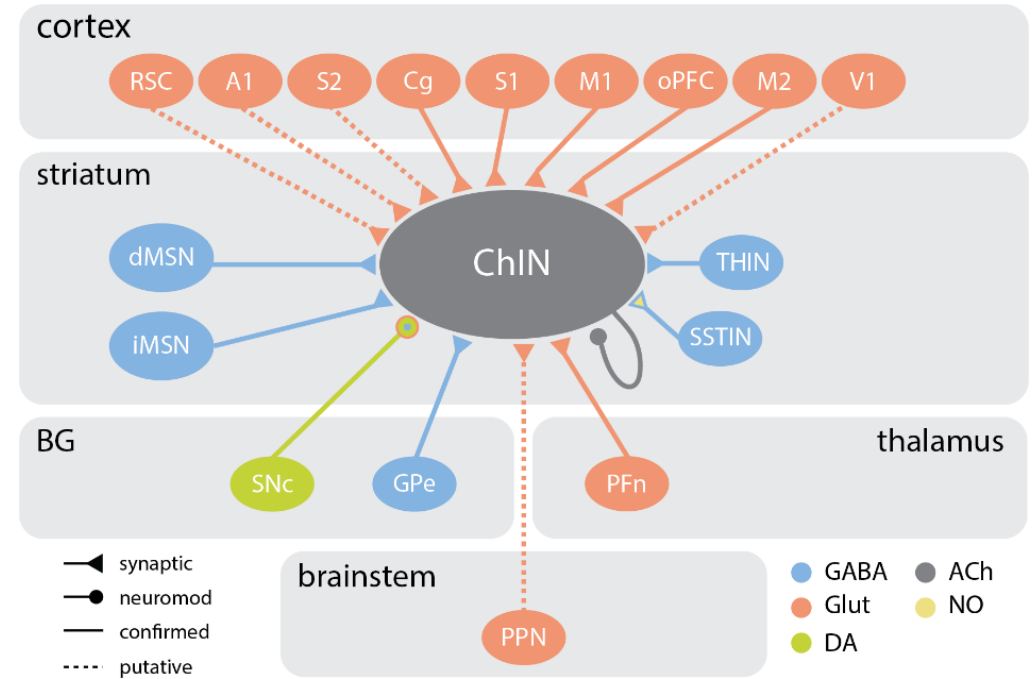
Figure 2. Schematic of major inputs to striatal cholinergic interneurons. Cortical inputs to cholinergic interneurons (ChINs) include the cingulate cortex (Cg), orbital prefrontal cortex (oPFC), primary somatosensory (S1) and motor (M1) cortices, and secondary motor cortex (M2). Putative cortical inputs to ChINs include the secondary somatosensory cortex (S2), primary visual (V1) and auditory (A1) cortices, and the retrosplenial cortex (RSC). Other extrastriatal inputs to ChINs include basal ganglia (BG) structures substantia nigra pars compacta (SNc) and external globus pallidus (GPe), the parafascicular thalamic nucleus (PFn), and the brainstem pedunculopontine nucleus (PPN). Intra-striatal inputs to ChINs include medium spiny neurons (MSN), tyrosine hydroxylase-expressing interneurons (THIN), somatostatin-expressing interneurons (SSTINs; or LTSI), and ChIN automodulation. Note: connections shown based on neuroanatomical tracing and optogenetic mapping studies [89,95].